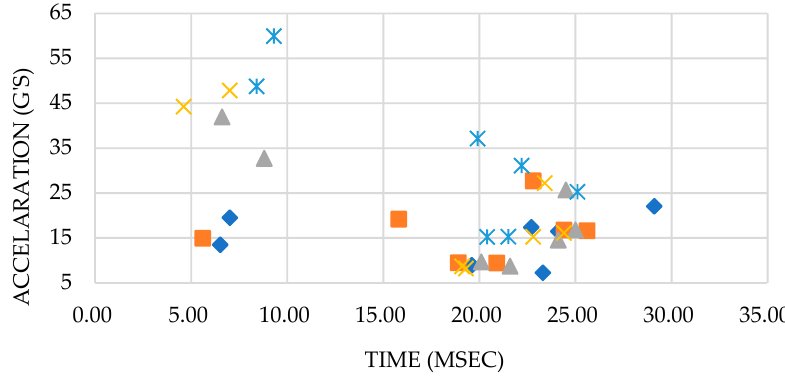
Figure 18. Acceleration (G’S) vs. Time (msec).